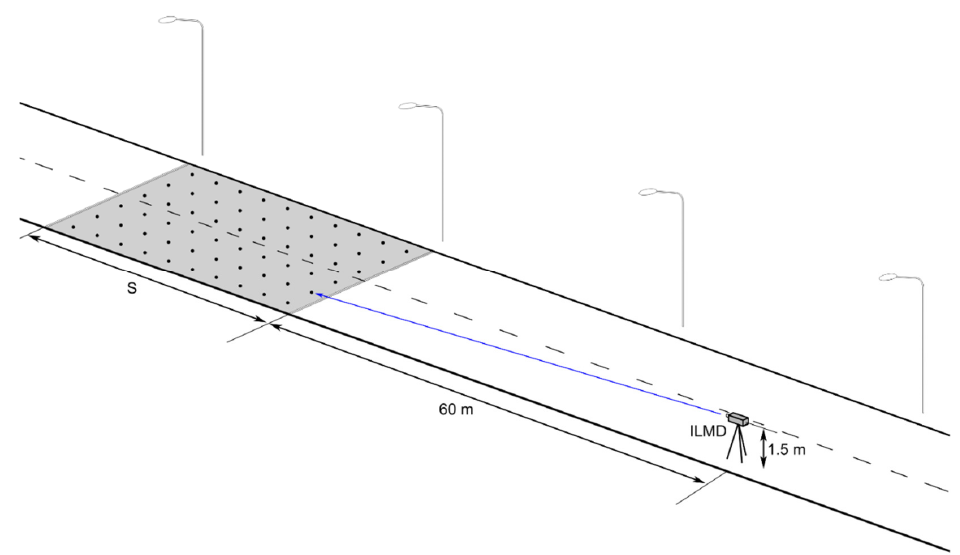
Figure 11. View of the measuring system used to determine the road luminance distribution where S is equal to 25 m— distance (module) between luminaires, 60 m—distance of the luminance meter from the measuring field, 1.5 m—height of the luminance meter placement, ILMD—image luminance measuring device Techno Team LMK 98-3 Color, the line from ILMD shows exemplary aiming of the meter at one of the measuring points.